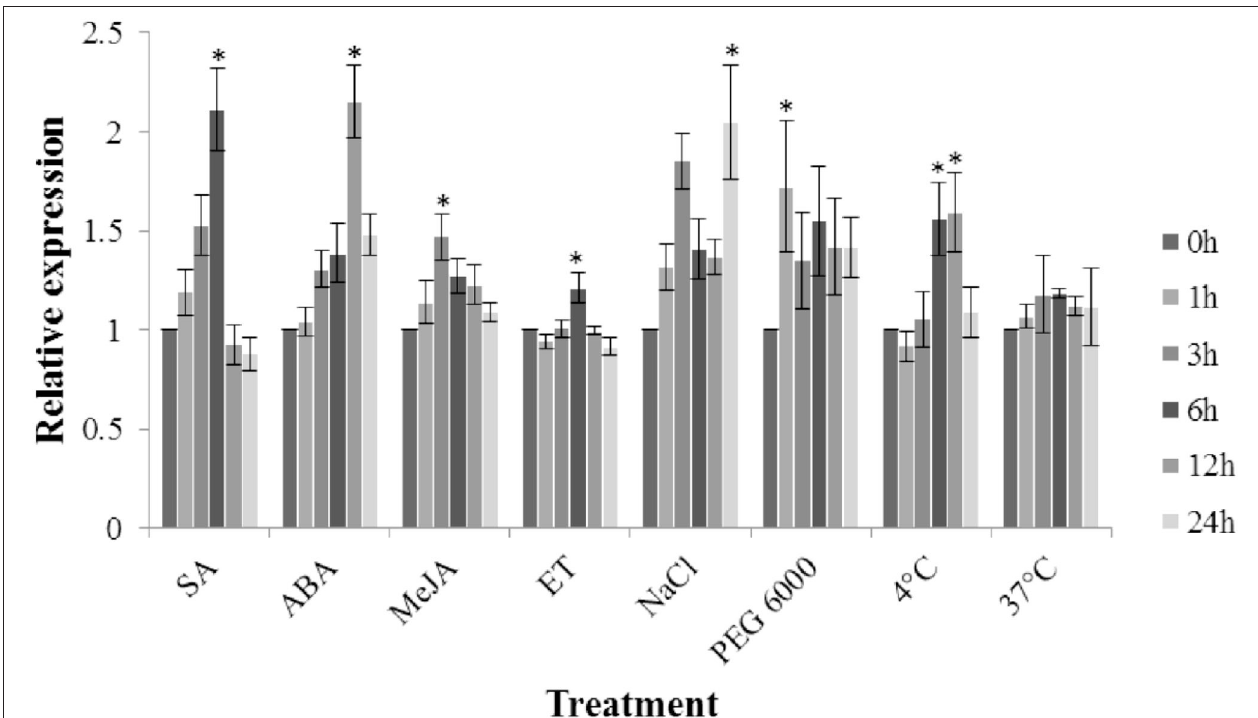
FIGURE 7 | Expression analysis of TaFBN under different hormones and abiotic stresses. SA, salicylic acid; ABA, abscisic acid; MeJA, methyl jasmonate; ET, ethylene. Error bars represent the variations among three independent replicates. The data were normalized to the TaEF-1 α gene. Wheat leaves treated with distilled water were included as a control. Error bars represent the standard deviations of three independent samples. The significance of differences is indicated by asterisks and tested using Student’s t -test ( P <